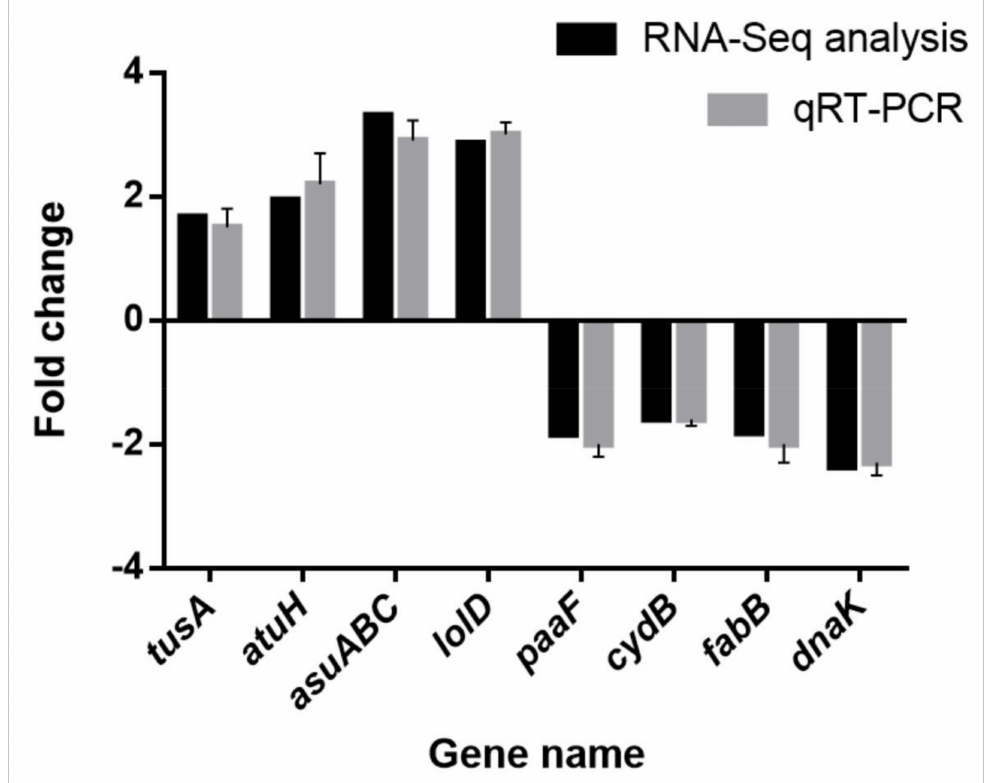
Figure 12. Validation of RNA sequencing data by quantitative real-time PCR. Note: The data represent the means ± standard deviation of the